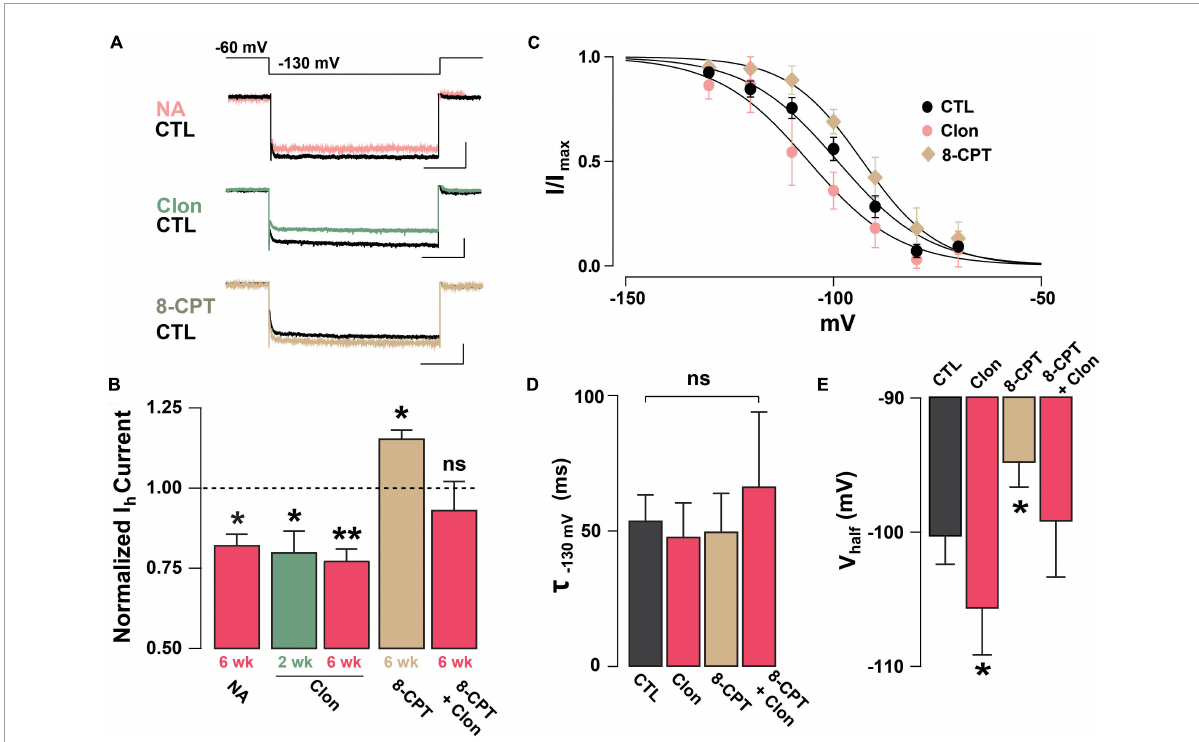
FIGURE3 Noradrenaline reduces I h in adult-born GCs via activation of α 2 -ARs. (A) Top: example traces of I h elicited with a hyperpolarizing step from –60 to –130 mV, control (CTL) and in the presence of drugs. NA reduced the I h in a GC 6 week post-labeling (CTL, black; NA 10 µ M, pink). A similar reduction is elicited by the selective α 2 -AR agonist, clonidine (Clon, 10 µ M, green). In contrast, application of a membrane-permeable cAMP analog, 8-CPT-cAMP (100 µ M, tan) produced an increase in I h . The calibration is 50 pA and 500 ms. (B) Summary bar graphs for the effect of the pharmacological treatments on the normalized I h amplitude at –130 mV, with respect to control. NA and Clon reduced the I h amplitude in GCs (NA, 6 weeks, n = 4 cells, * p = 0.02; Clon, 2 weeks, n = 6 cells, * p = 0.03; Clon, 6 weeks, n = 7 cells, ** p = 0.001), while I h amplitude is increased by the addition of 8-CPT-cAMP ( n = 5 cells, * p = 0.01). In the presence of 8-CPT-cAMP plus Clon, the I h amplitude was not significantly different from CTL ( n = 5 cells, p = 0.45). (C) Boltzmann fits for the voltage dependency of activation of I h in GCs 6 weeks post-injection showing that activation of a2-ARs by Clon and application of 8-CPT-cAMP shifts the voltage dependency of I h in opposite directions. (D) Summary bar graphs showing that the application of Clon or 8-CPT-cAMP does not alter the activation kinetics of I h (Clon, p = 0.16; 8CPT, p = 0.54; 8CPT + Clon, p = 0.35). (E) α 2 -AR activation shifts the half-activation potential (V half ) to more negative potentials (* p = 0.04), whereas 8-CPT-cAMP shifts the V half to more positive potentials (* p = 0.02). There was no change in Vhalf with both 8-CPT-cAMP and Clon ( p =